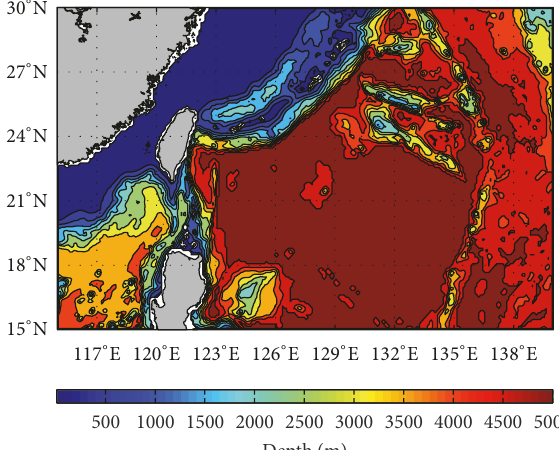
Figure 2: Model domain and bathymetry (m).